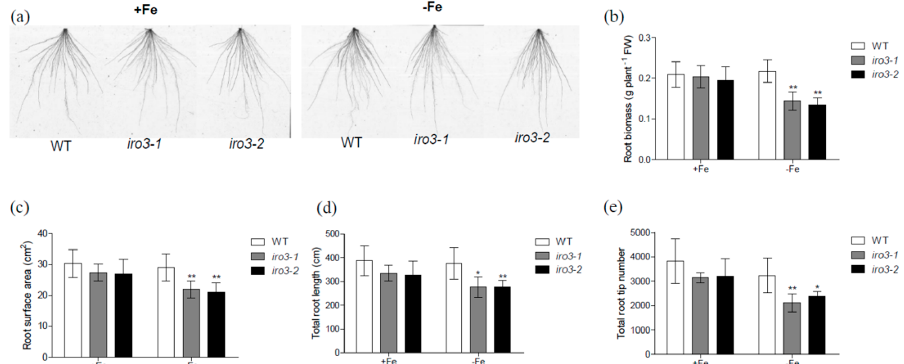
Figure 3. Root phenotype analysis of iro3 mutants. ( a ) Root growth performance of WT and iro3 mutants grown under +Fe or − Fe conditions. ( b – e ) Root parameters of WT and iro3 mutants grown under +Fe or − Fe conditions. Root biomass ( b ), root surface area ( c ), total root length ( d ), and total root tip number ( e ) of WT and iro3 mutants under +Fe and − Fe conditions. Fourteen-day-old seedlings were transferred to − Fe or + Fe for 8 d. The iro3-1 mutant contains an insertion of ‘A’; the iro3-2 mutant contains an insertion of ‘T’. Data are given as the means ± SD of six biological replicates. All data were compared with the WT. Asterisks indicate significant di ff erences of WT and iro3 mutants based on two-tailed Student’s t test (* p < 0.05, ** p <